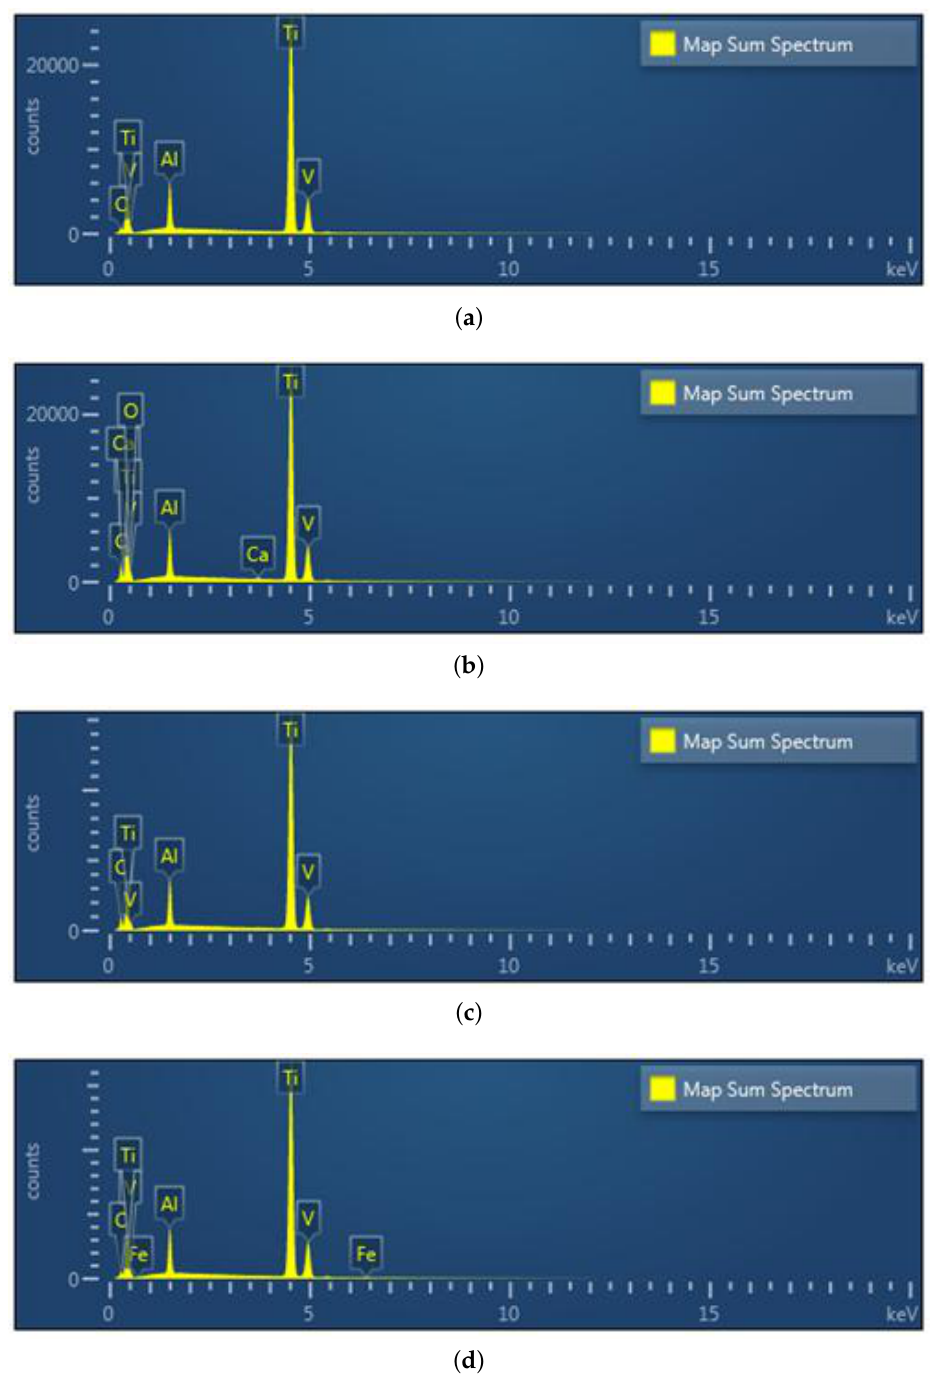
Figure 17. EDS spectrum analysis of the material samples. ( a ) Material sample A; ( b ) Material sample A-H; ( c ) Material sample B; ( d ) Material sample